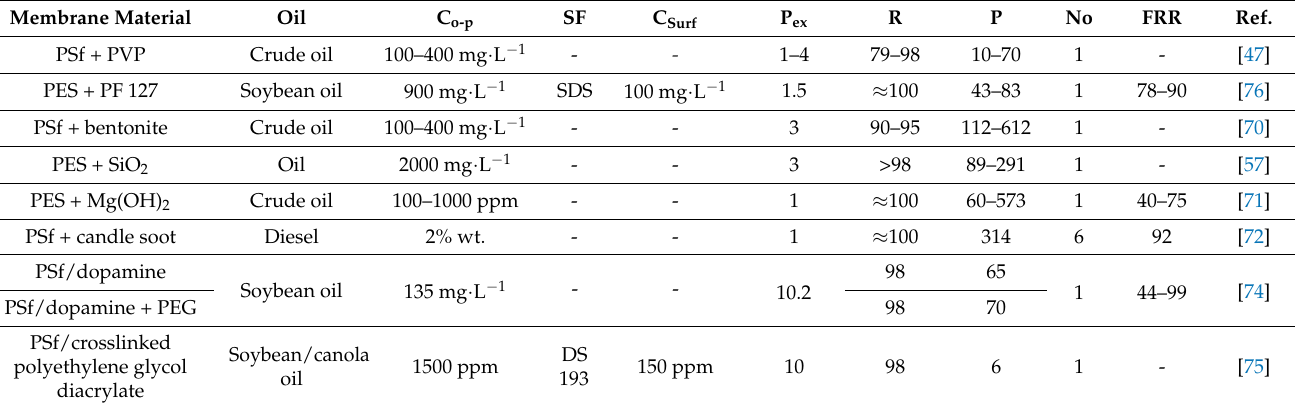
Table 3. Membranes based on PSf and PES for the separation of water-oil